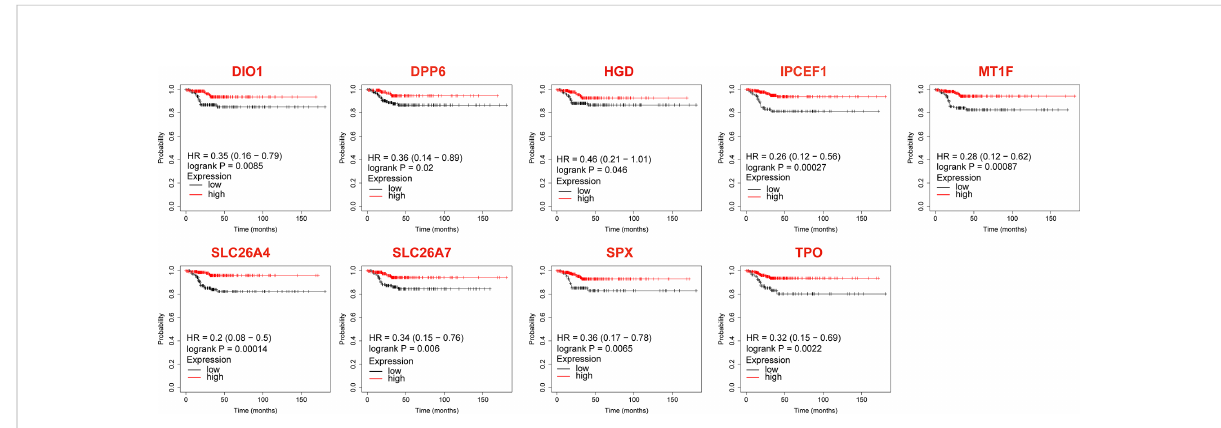
FIGURE 5 The Relapse-free survival of differentially expressed genes in thyroid cancer after validation by clinical